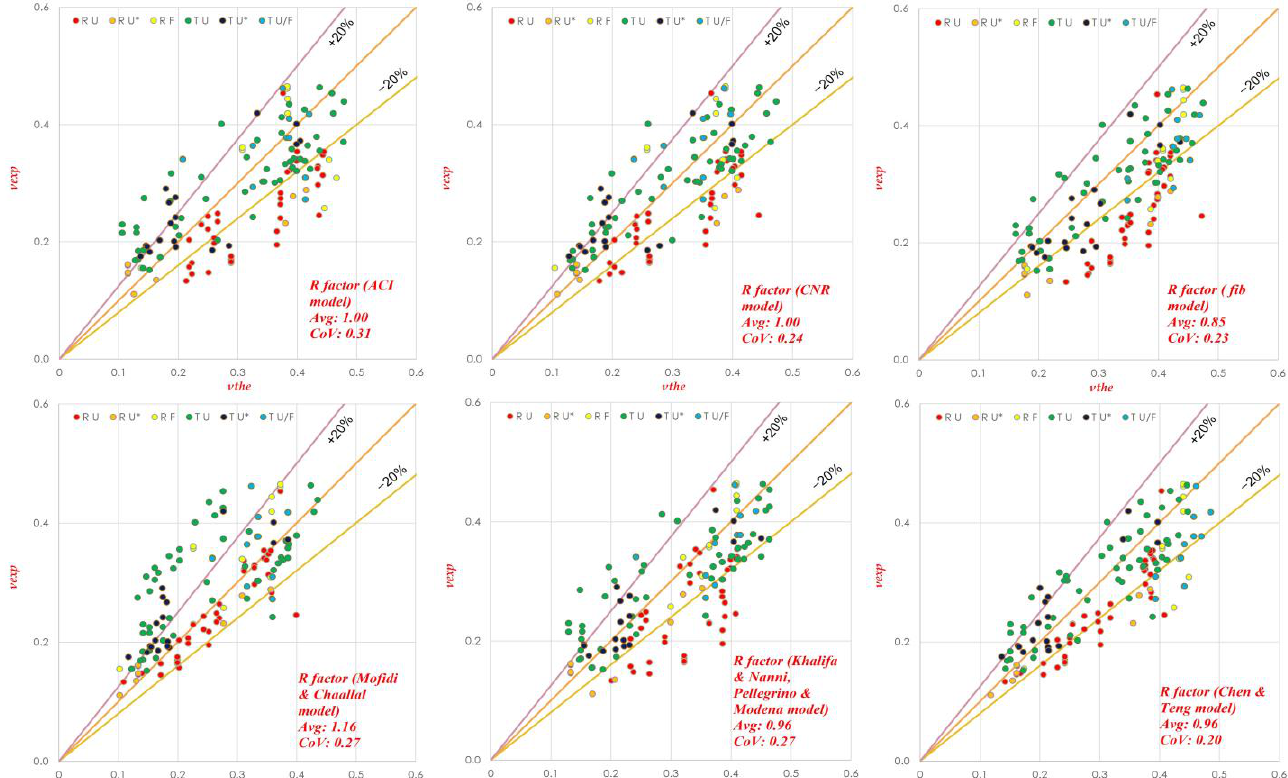
Figure 4. Experimental vs. theoretical shear strength for the Colajanni et al. model with six different R factors. (Data Set 1, α = β ) . RU* and TU* represents Rectangular and T beam having U-jacketing with partially efficient anchorages.